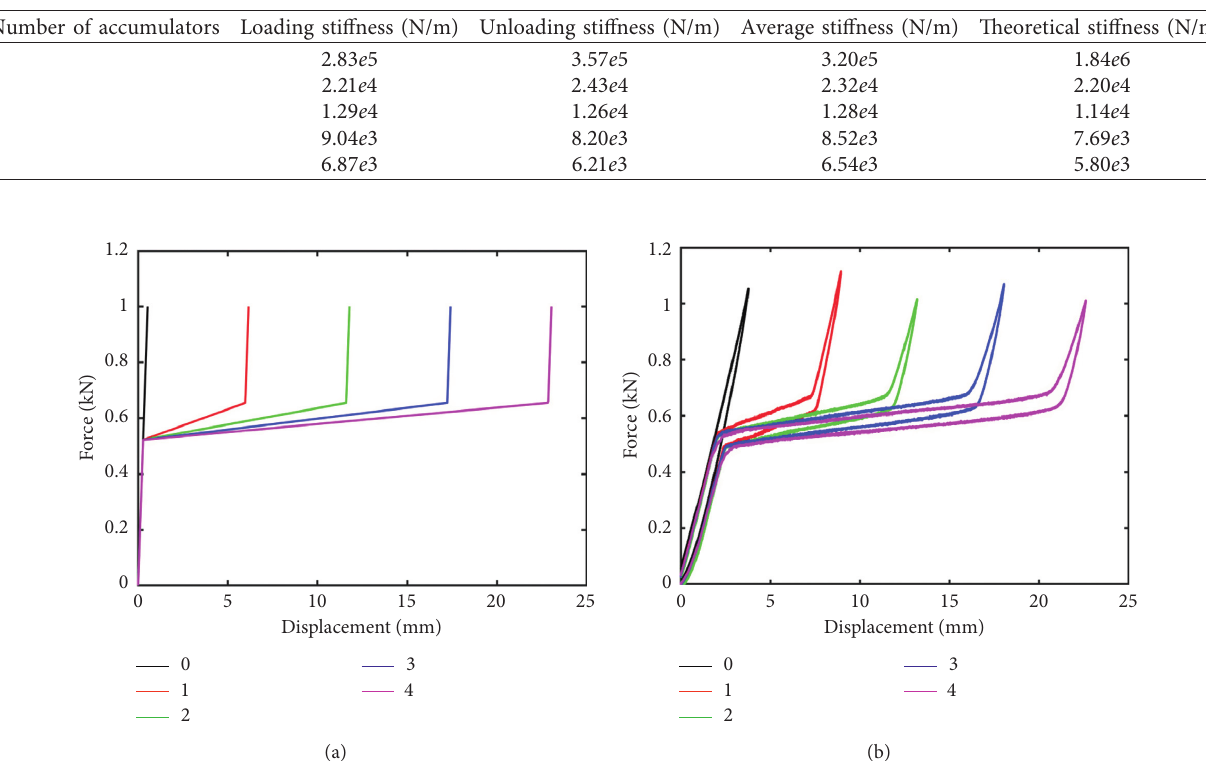
Figure 3: Stiffness property of the MMSI. (a) Theoretical force-displacement relationships of the MMSI with different number of elements. (b) Experimental force-displacement relationships of the MMSI with different number of